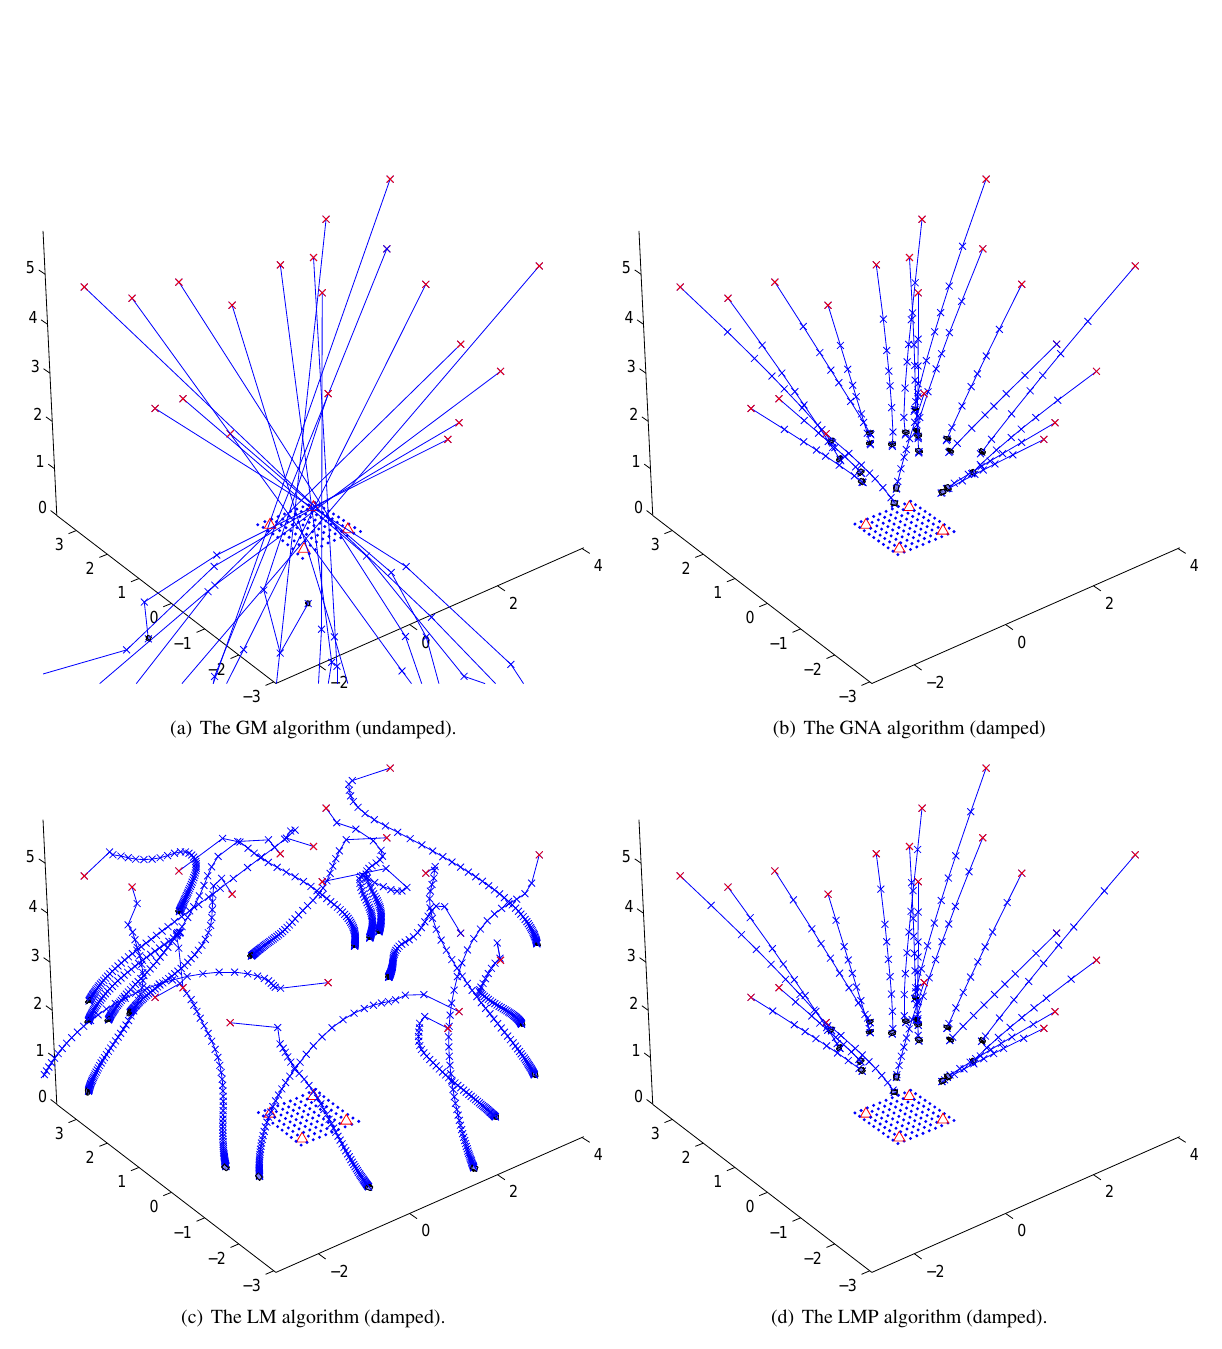
Figure 4: Iteration trace of the EO parameters for the four bundle algorithms on data set 3 with f 0 = 3 f ∗ . The initial EO positions, same for all algorithms, are indicated by red crosses. The EO positions at subsequent iterations are indicated by blue crosses. The GM method (a) makes an early over-correction where the cameras end up on the wrong side of the target. After that the GM method never recovers. For the the GNA (b) and LMP (d) algorithms, damping is active during the first iterations and stops the updates from becoming too large. Near the solution, damping is relaxed and no damping is required during the final iterations. The LM algorithm (c) oscillates between damped and undamped and makes an early over-correction of the rotation angles after which is does not recover in the allowed number of iterations. The shown results are typical for m > 2 for all data sets and